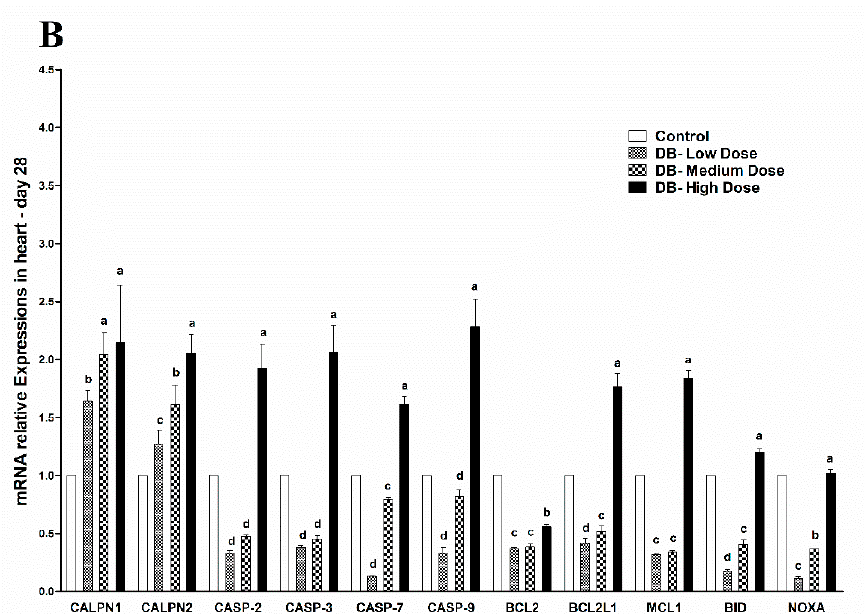
Figure 8. Effects of BD supplementation on heart mRNA expressions of apoptosis-related genes at 07 days ( A ) and 28 days ( B ) of age. Data are presented as mean value ± SEM (n = 6). Values without the same mark (a–d) represent statistically significant differences ( p < 0.05). CALPN1, Calpain 1; CALPN2, Calpain 2; CASP-2, Caspase 2; CASP-3, Caspase 3; CASP-7, Caspase 7; CASP9, Caspase 9; BCL2, B-cell CLL/lymphoma 2; BCL2L1, BCL2 like 1; MCL1, myeloid cell leukemia sequence 1; BID, BH3 interacting domain death agonist; NOXA, similar to ATL-derived PMA-responsive peptide; Denatonium benzoate- Low Dose treated group, Denatonium benzoate- Medium Dose treated group, Denatonium benzoate- High dose treated group.